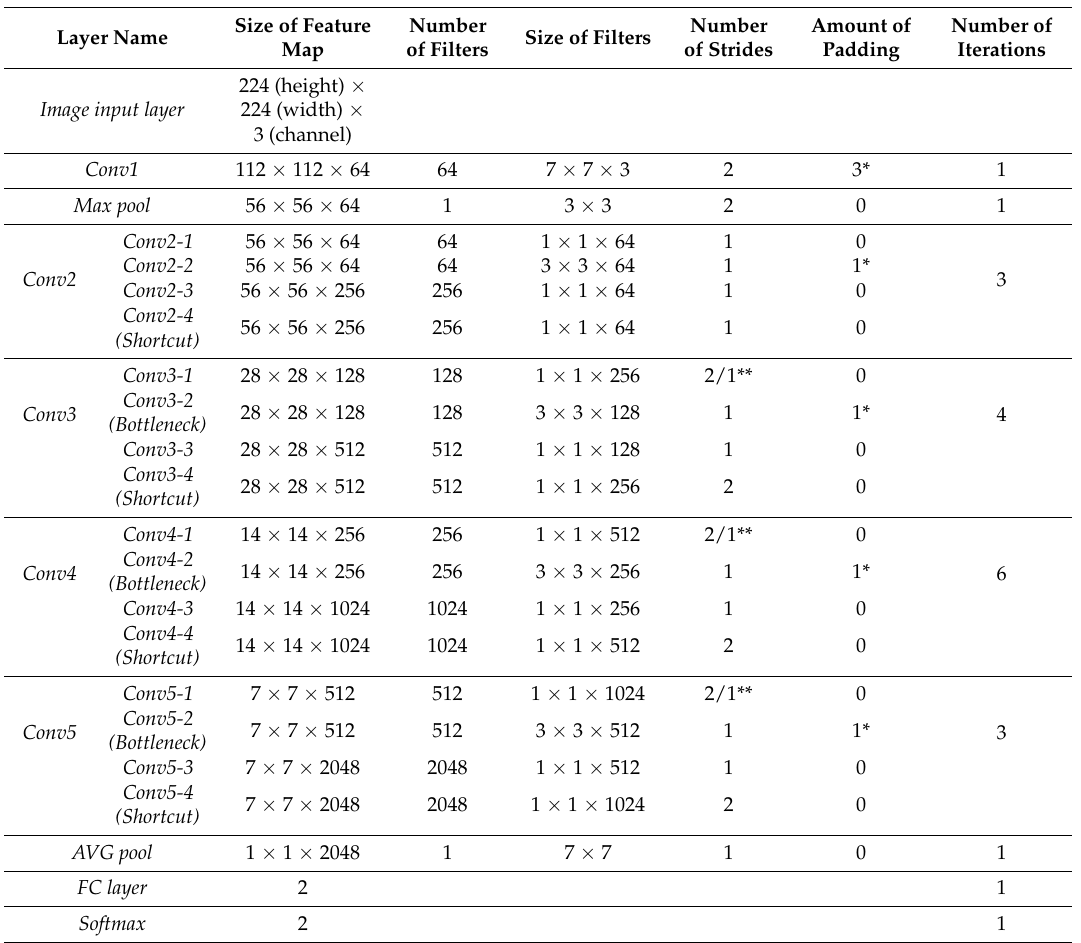
Figure 2. The structure of proposed CNN. Table 2. Output size, numbers and sizes of filters, number of strides, and padding in our deep residual CNN structure (3* represents that 3 pixels are included as padding in left, right, up, and down positions of input image of 224 × 224 × 3 whereas 1* shows that 1 pixel is included as padding in left, right, up, and down positions of feature map) (2/1** means 2 at the 1st iteration and 1 from the 2nd iteration).